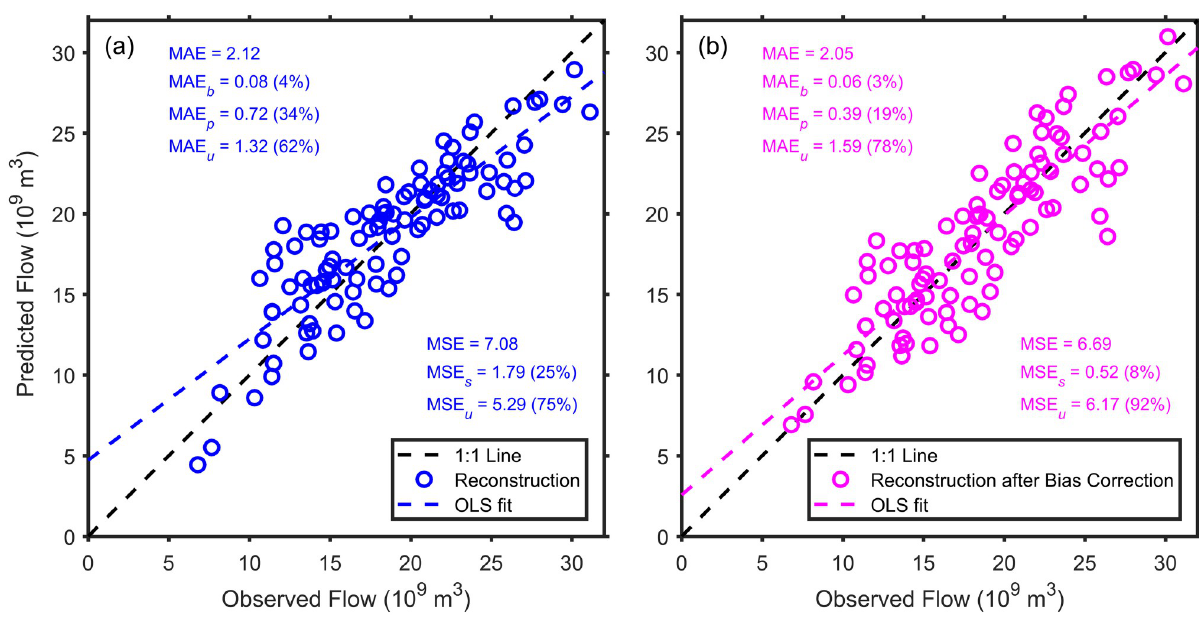
Fig 2. Model-estimation errors before and after bias correction. Model-estimation errors for (a) the reconstruction of annual Upper Colorado River flow (in billions of cubic meters) from [15] and (b) the same reconstruction after applying the bias-correction procedure of [14].